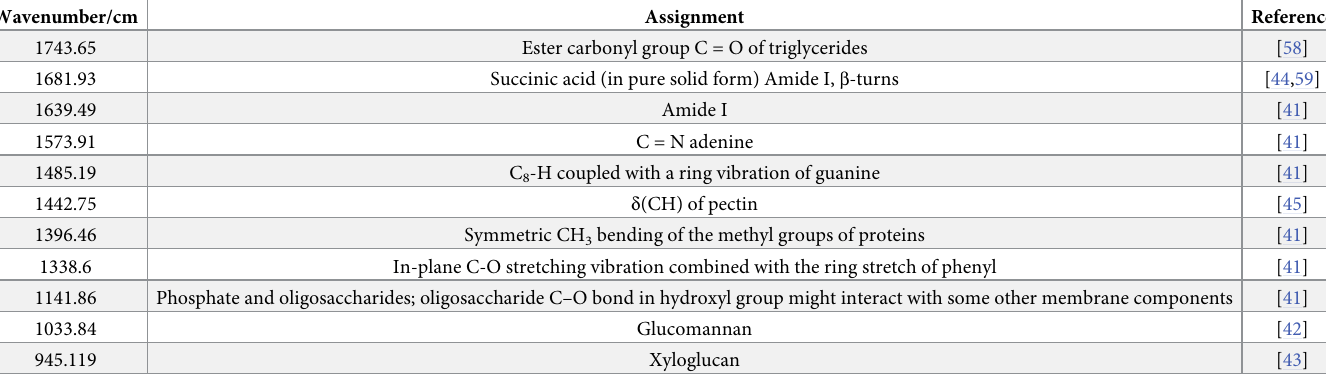
Table 3. Main wavenumbers responsible for class differentiation between the highly invasive Reynoutria japonica var. japonica and its more easily controllable counterpart Reynoutria japonica var. compacta , and their assigned biomarkers.